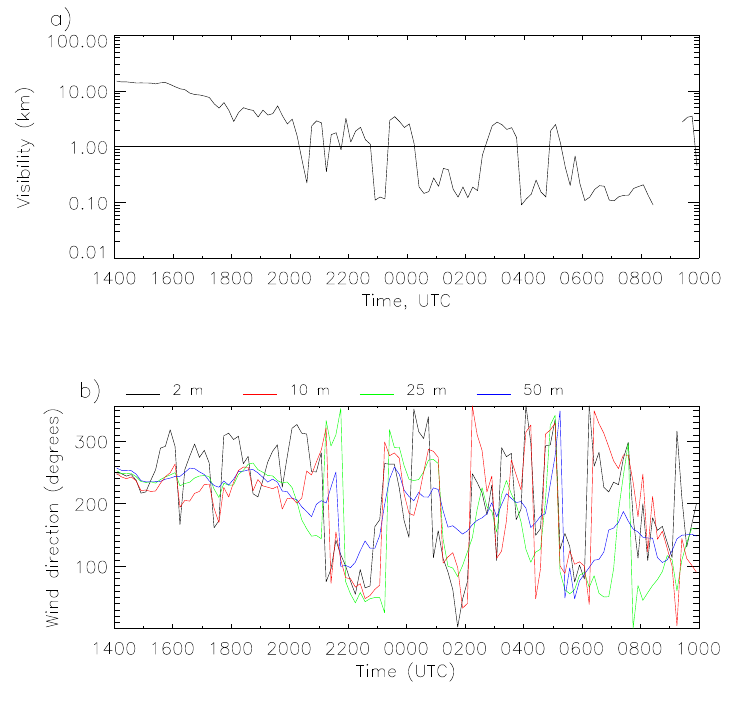
Figure 13. Meteorological data for 27–28 December 2016: ( a ) visibility and ( b ) wind direction.